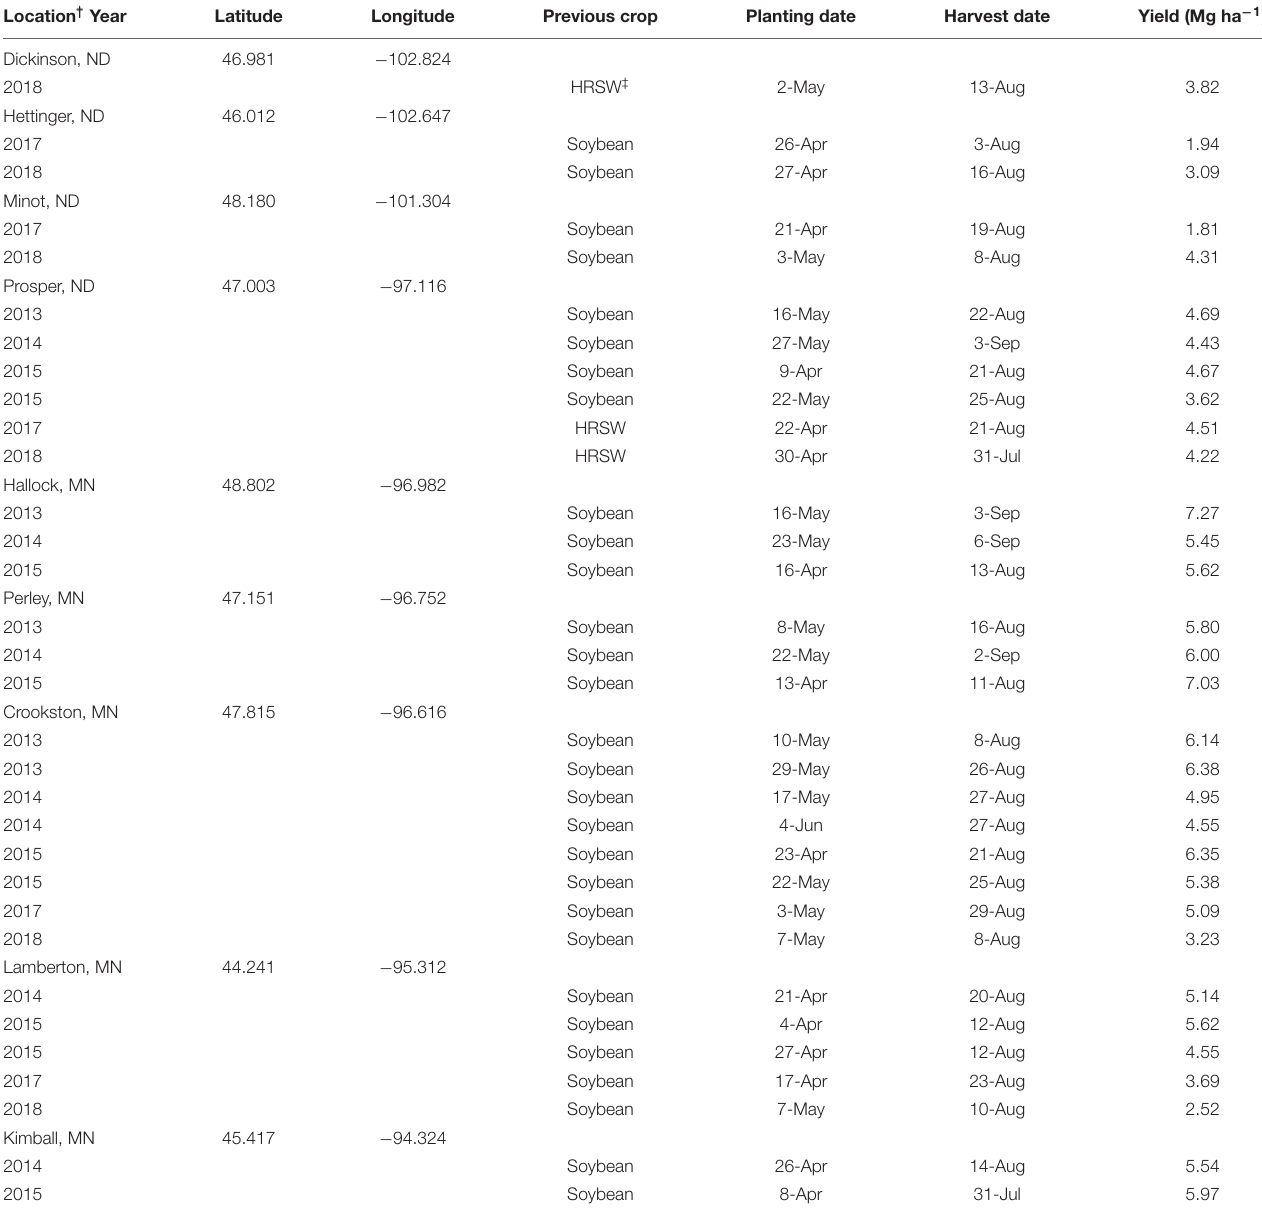
TABLE 2 | Location and year details for 32 environments in North Dakota and